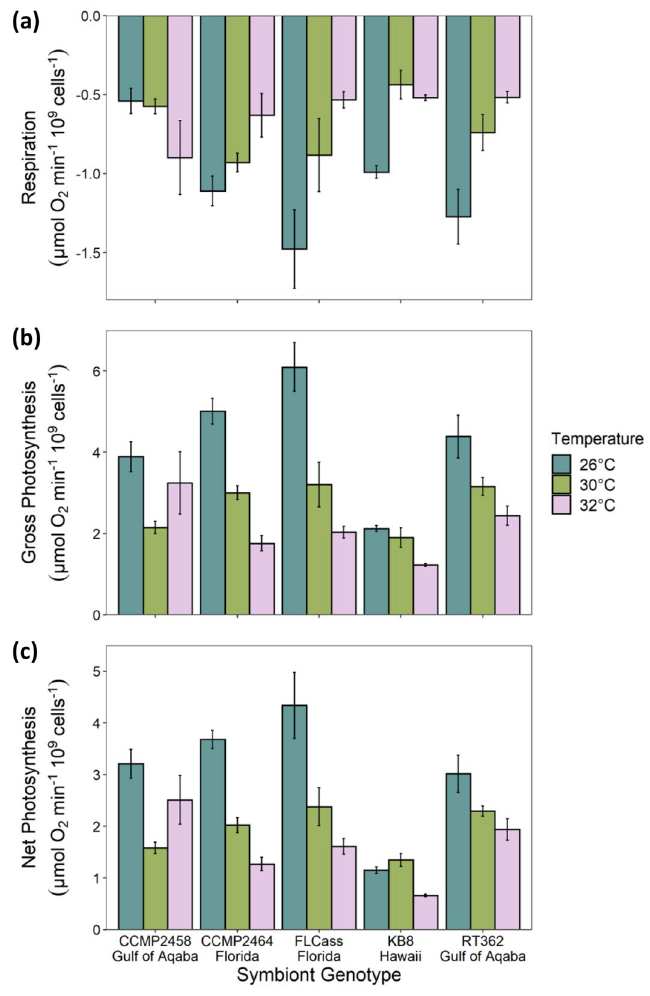
Figure 2. ( a ) Respiration ( P < 0.001), ( b ) gross photosynthetic ( P < 0.001), and ( c ) net photosynthetic ( P < 0.001) rates of five symbiont genotypes measured in vitro at 26 °C, 30 °C, and 32 °C. Values represent mean ± SE, n =